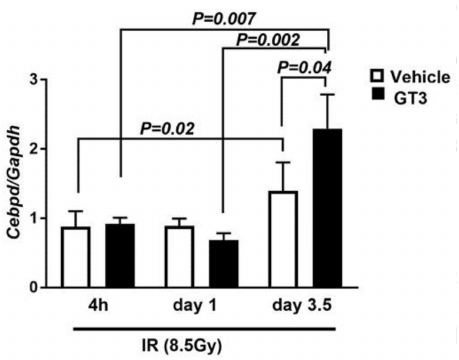
Figure 5. Cebpd is upregulated by IR and combination of IR and GT3 in the intestine tissues. The intestinal expression of Cebpd and Gapdh transcripts were analyzed in Cebpd + / + mice at 4 h, 1 day and 3.5 days post-exposure to 8.5 Gy. The data are expressed as fold change relative to 4 h vehicle-treated Cebpd +/+ mice. The data are presented as mean + S.E.M. of n = 4–8 mice per treatment per